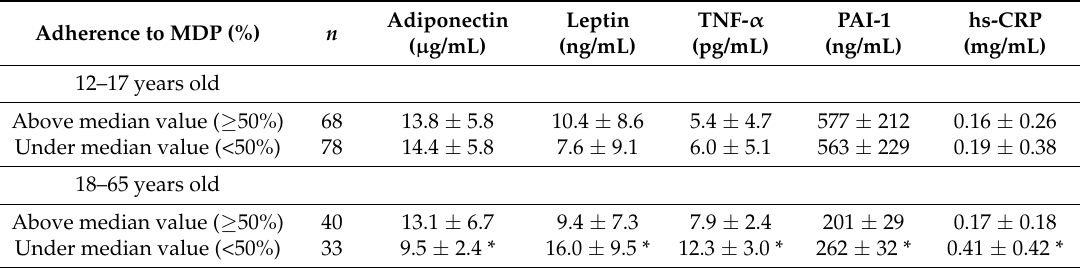
Table 2. Levels of inflammatory markers in adult male subjects according to the adherence to the MDP. Adherence to MDP